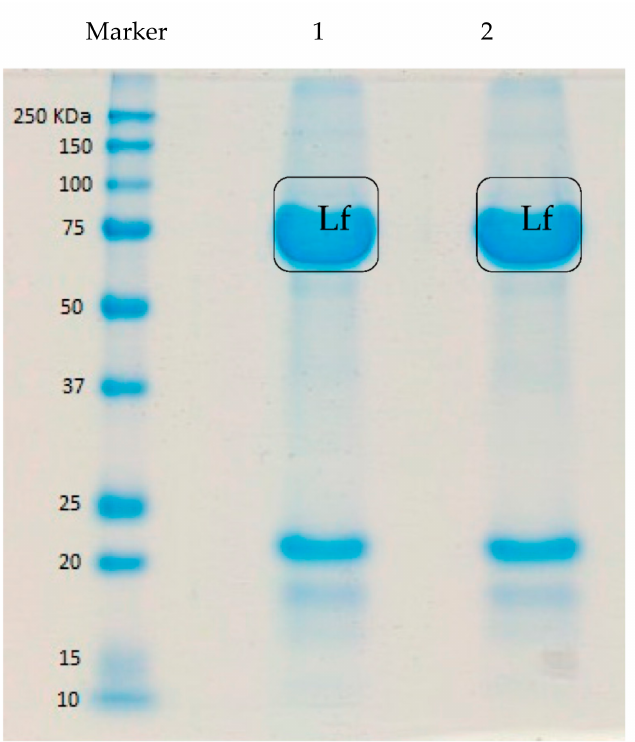
Figure 2. Sodium dodecyl sulfate-polyacrylamide acrylamide gel electrophoresis (SDS-PAGE) of lactoferrin (Lf) obtained by cation exchange chromatography from deer milk. Both lanes 1 and 2 are Lf isolated from deer